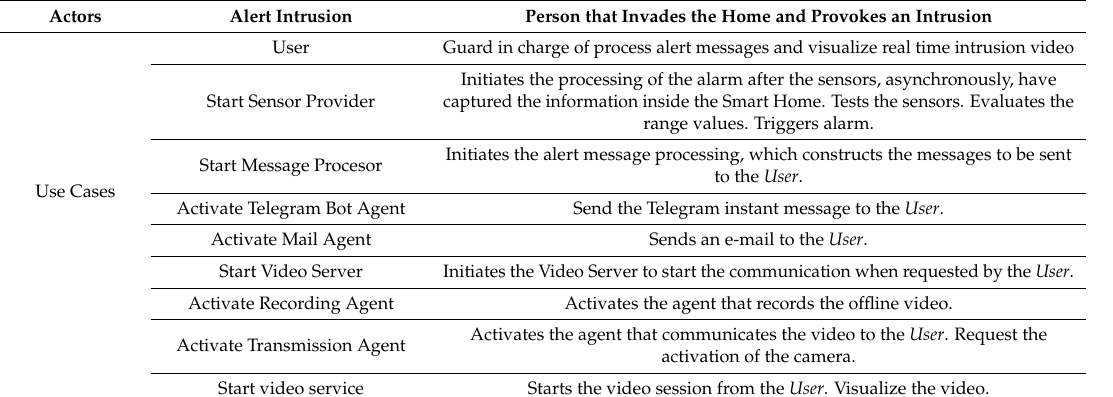
Table 1. Description of actors and use cases of Figure 2.